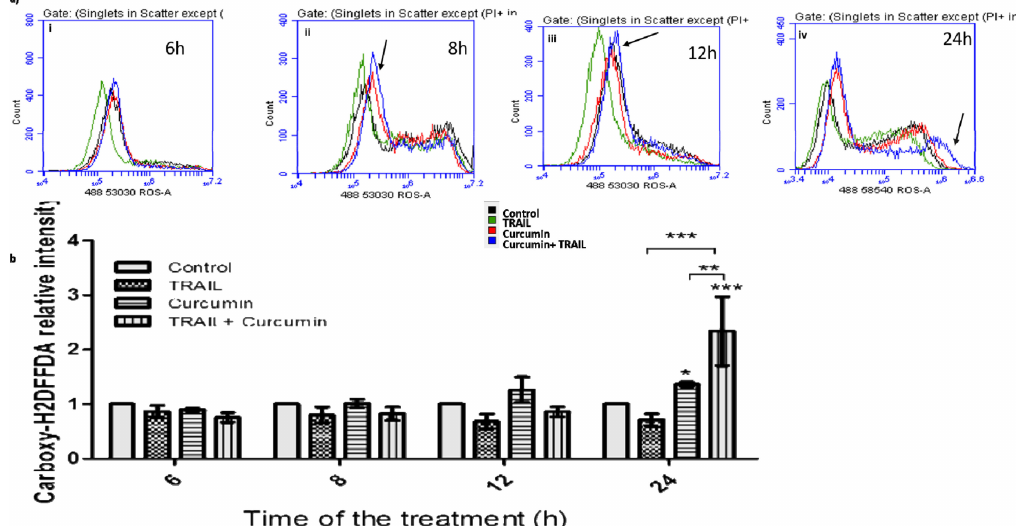
Figure 8. ROS induction by curcumin / TRAIL combination. ( a ) ACHN cells were cultured on six-well plates and treated with vehicle control or 25 µ M curcumin for 4 h, followed by a further incubation with 50 ng / mL TRAIL for an additional 2, 4, 8 and 20 h. Therefore, the final exposure length was ( i ) 6, ( ii ) 8, ( iii ) 12 and ( iv ) 24 h. ROS was measured using Carboxy-H2DFFDA probe and analysed by flow cytometry. Negative control cells were incubated with 0.05% DMSO containing complete culture medium only. Arrows indicate a high ROS level following curcumin + TRAIL compared to the other treatments. ( b ) Flow cytometry data was presented as mean relative fluorescent intensity ± SEM of three independent experiments. Two-way ANOVA was used to analyse the